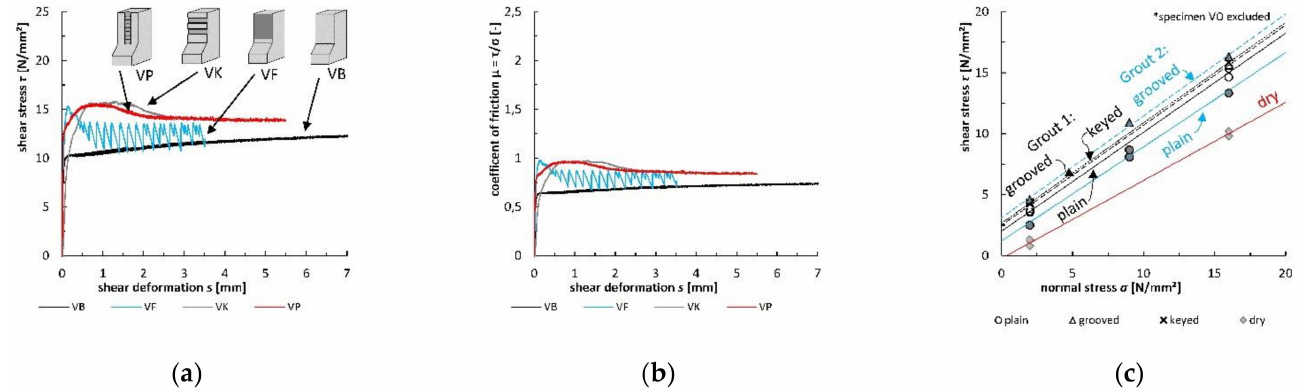
Figure 14. Load carrying characteristic of different joint types: ( a ) τ / s –relationship; ( b ) µ / s –relationship; ( c ) τ max vs. σ